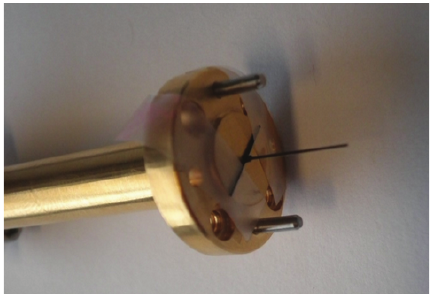
Figure 11: The photograph of silicon antenna and